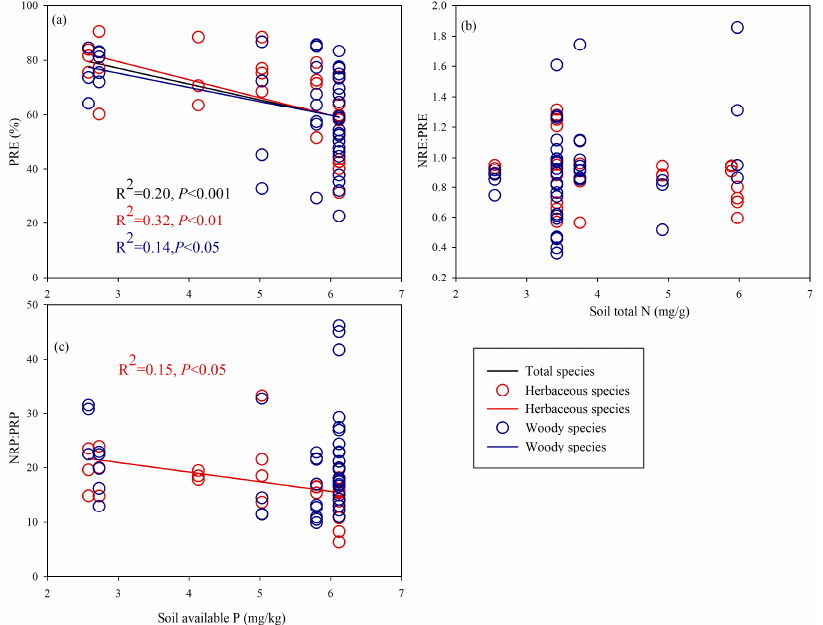
Figure 5. Regression relationships between the selected soil factors and three leaf nutrients. ( a ) Re- gression relationships between soil available P and PRE. ( b ) Regression relationships between soil total N and NRE:PRE (There's no regression line because all regressions are insignificant). ( c ) Re- gression relationships between soil available P and NRP:PRP. The value of R 2 and P of all significant regressions are given.